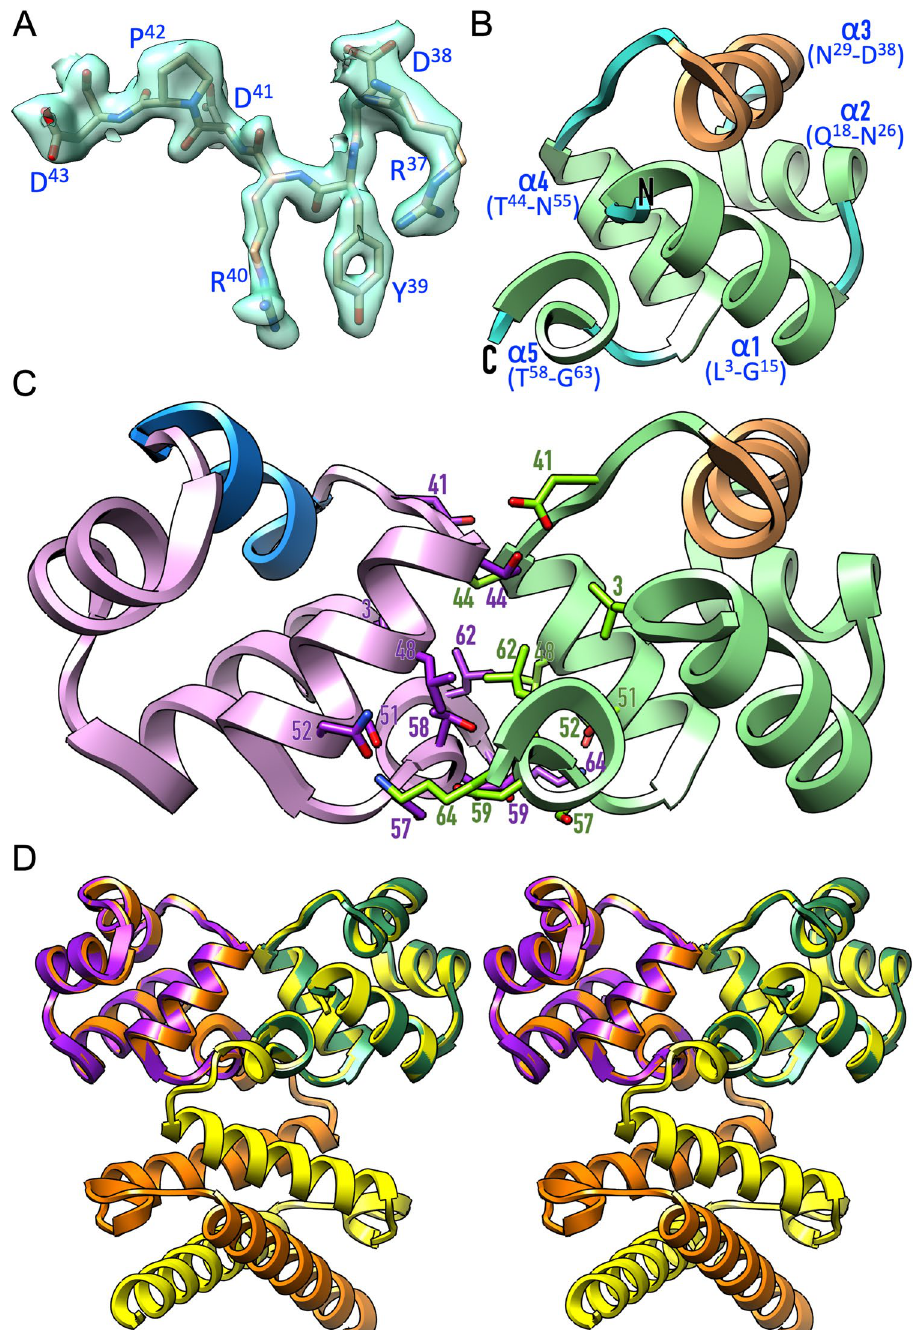
Figure 1. Structure of B. subtilis ImmR. (A) Representative fragment of the final (2m F obs − D F calc )-type Fourier map displayed at 1 σ above threshold as a semi-transparent turquoise surface, superimposed with segment R 37 –D 43 of the final refined experimental structure. (B) Ribbon-type plot of the ImmR DBD, which consists of five helices (α1–α5). The recognition helix is shown in sandy brown. (C) Dimeric arrangement of the ImmR DBD in the crystals. Each protomer is shown in one colour (light green and plum), except the recognition helices (sandy brown and dodger blue). Residues from each protomer contributing to the interface are shown as sticks, with carbons coloured as the respective ribbon, and labelled. (D) Superposition in cross-eye stereo of the experimental DBD dimer (chains in purple and green) and the predicted AlphaFold dimer of the full-length structure (chains in orange and